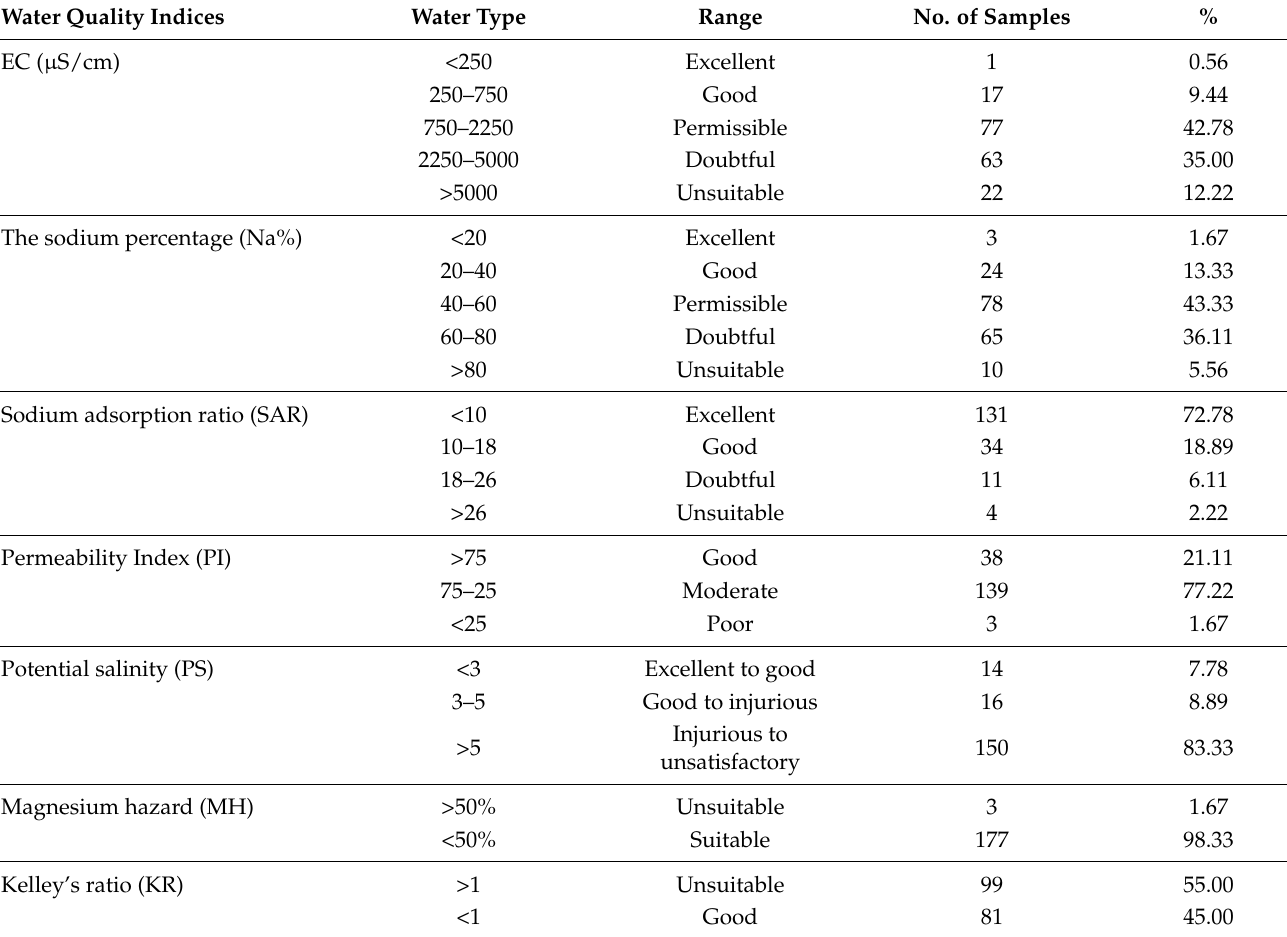
Table 3. Classification of the different water quality indices